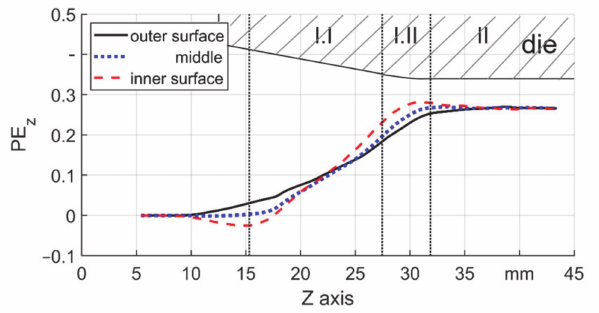
Figure 20. PE z distribution of s 0 = 3 mm and µ equals